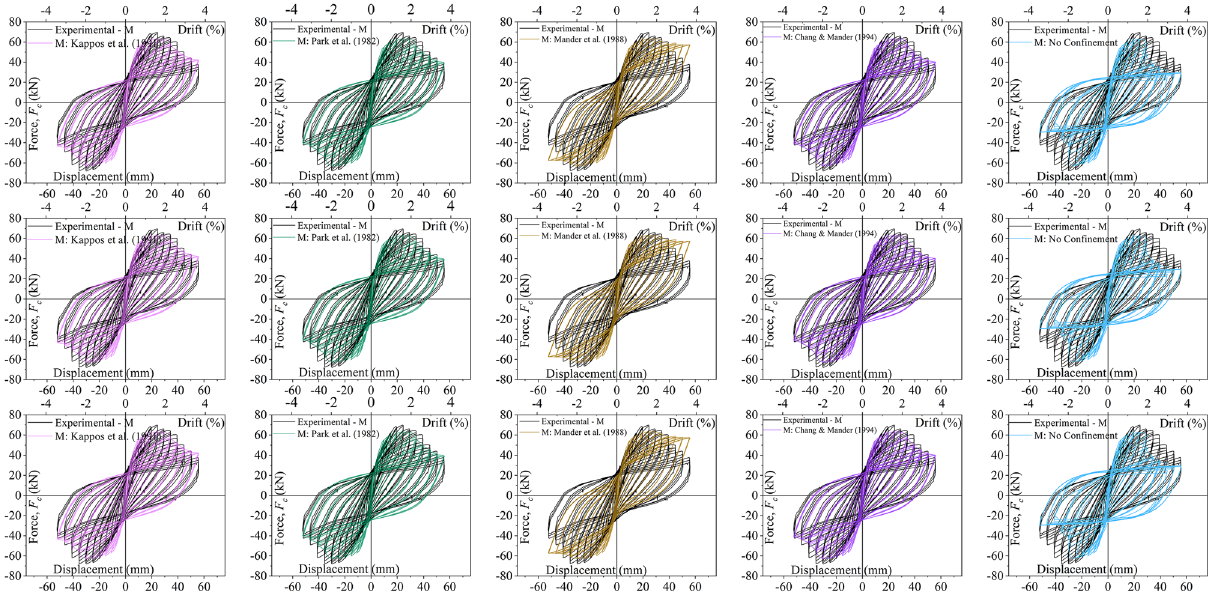
Figure 10. Lateral load–displacement relationship: column C (top row); column M (middle row); column L (bottom